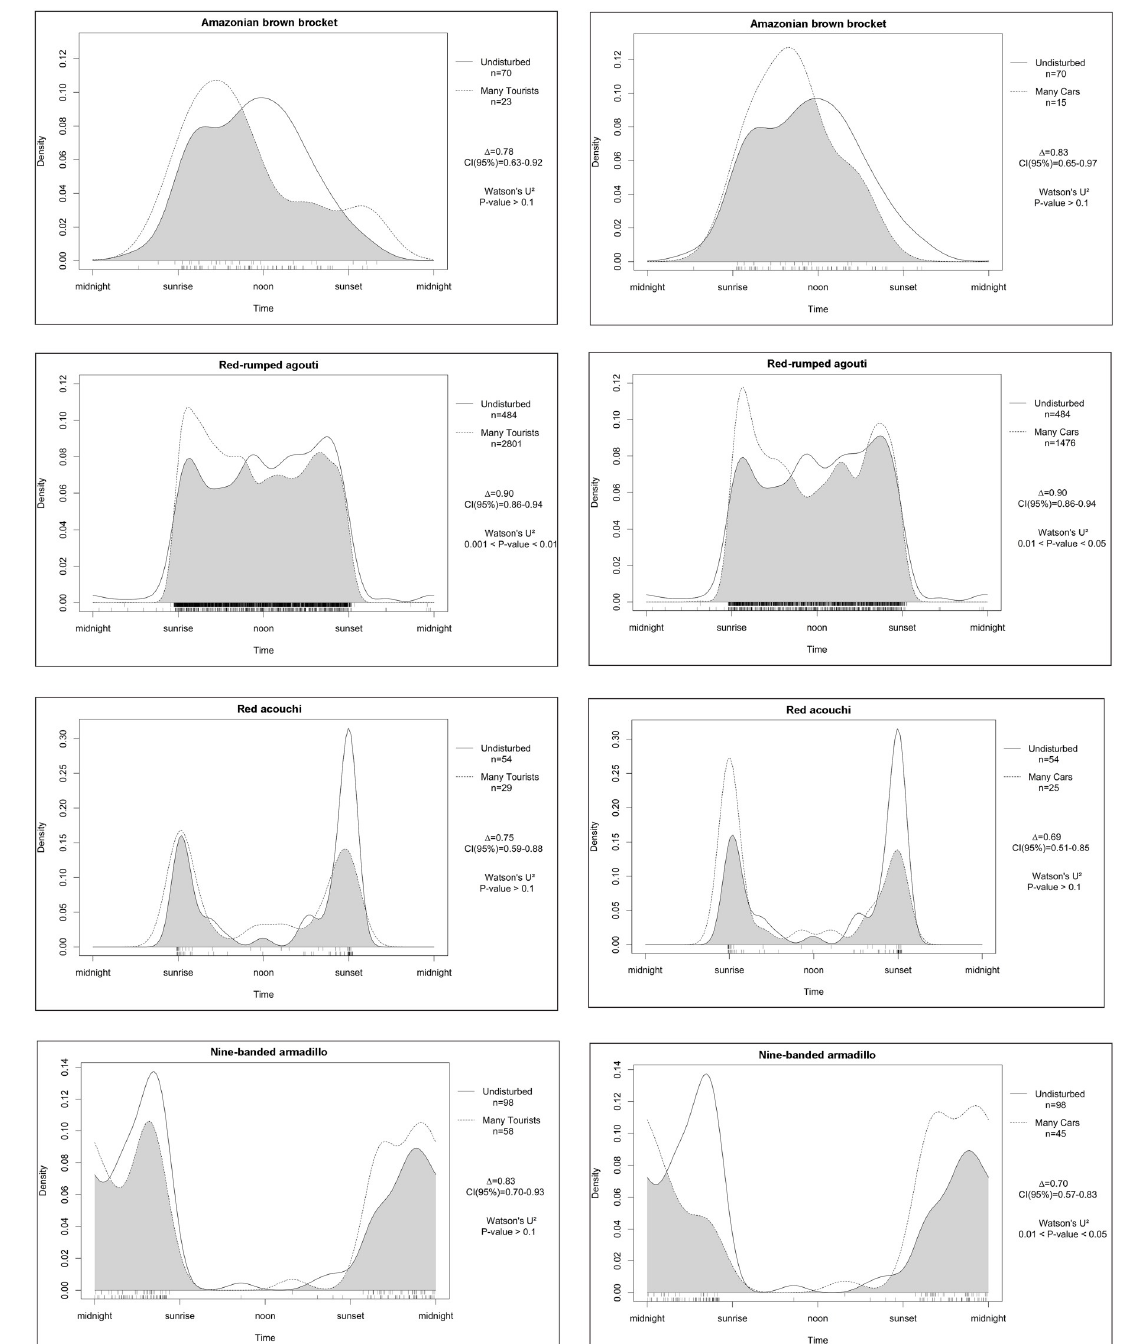
Fig 8. Differences in activity patterns of several diurnal, cathemeral and nocturnal non-predator species between undisturbed areas and areas with a high number of tourists (left) and many vehicles (right). hikers with a slight shift to more crepuscular and nocturnal activity (18% less diurnal activity). Traffic did not seem to have an impact on their diurnal activity. Red acouchi on the contrary became more crepuscular due to traffic, with a shift of 12%. No effect was seen in the other species.